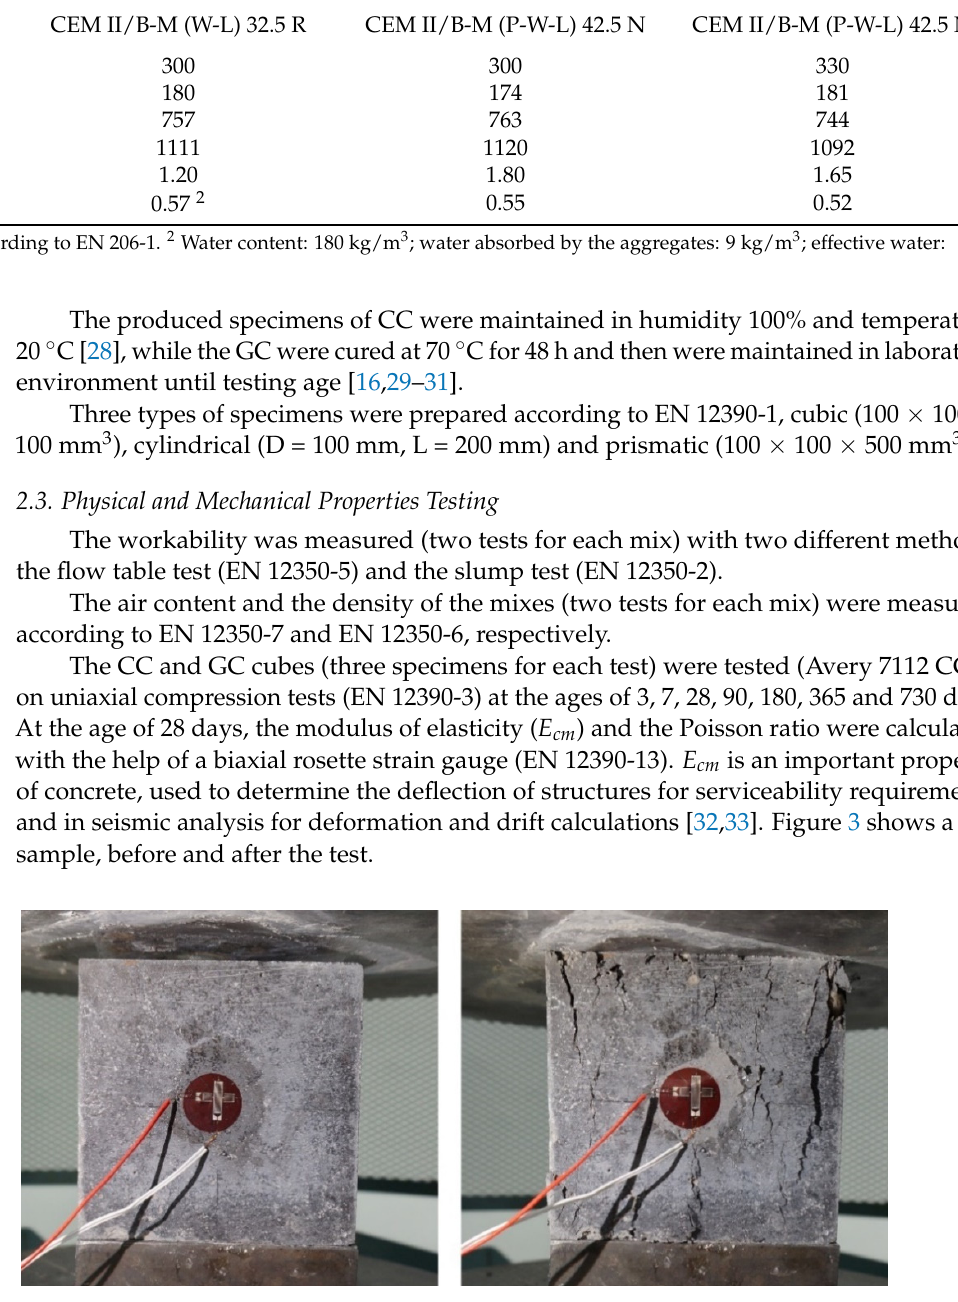
Figure 3. GC specimen with strain gauges before ( left ) and after ( right ) compression test.